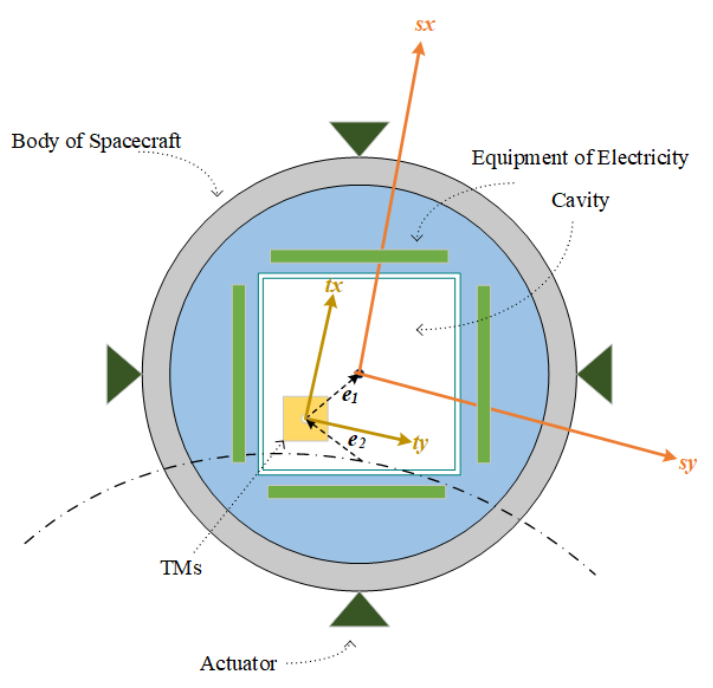
Figure 2. Relative error of drag-free